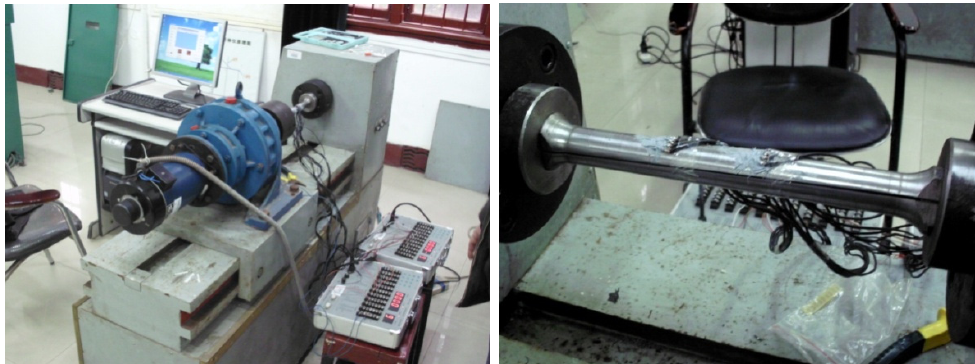
Figure 8. Torsion experiment of the thin-walled bar with an open cross-section.